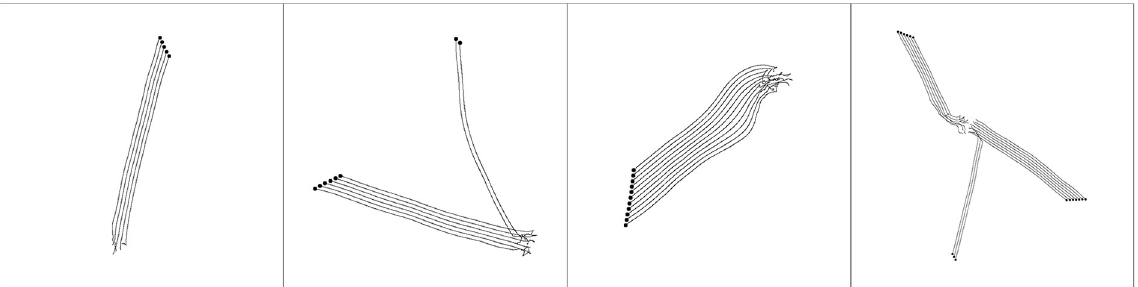
Fig 3. Example of the behaviour displayed by the highest-performing controller, with 5, 8, 11 and 16 robots, from left to right. The lines represent the trajectory of the robots.